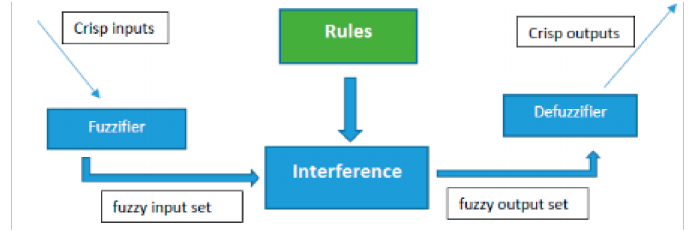
Figure 17. Example of a fuzzy logic system.